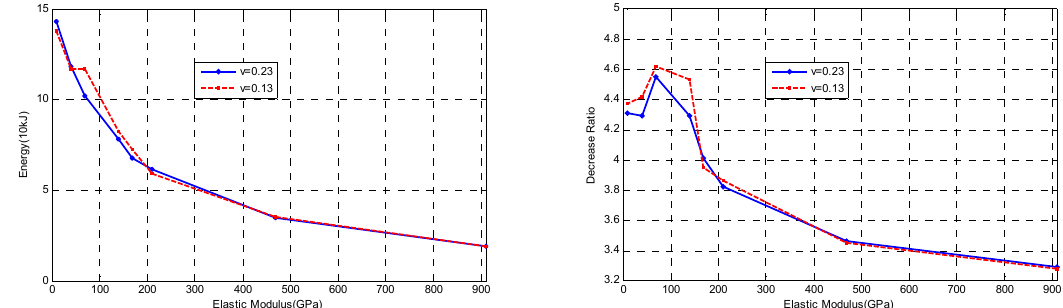
Figure 32. The comparison of energy and decrease ration vs. elastic modulus.